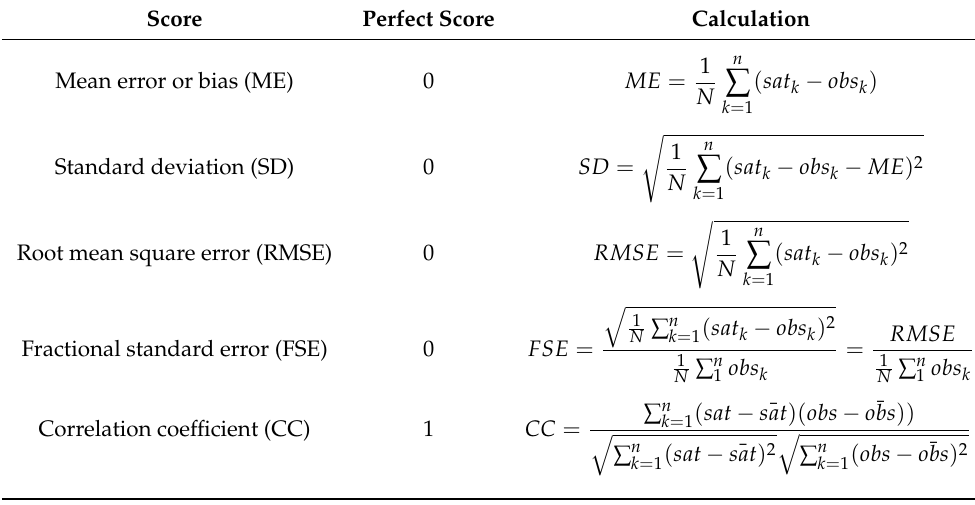
Table 2. Continuous statistical